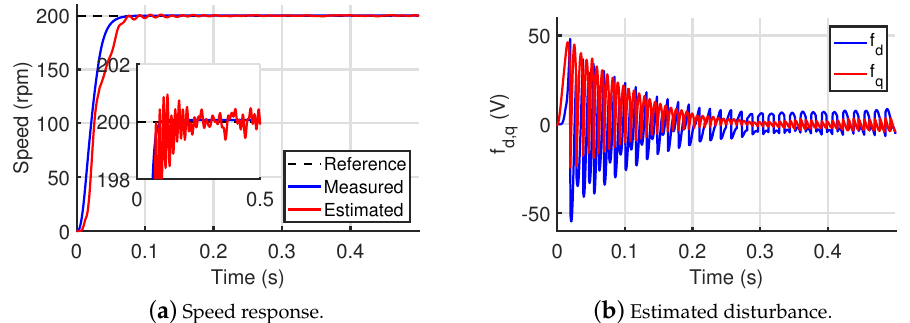
Figure 9. Simulation results under L = 2 L 0 , R = 10 R 0 .